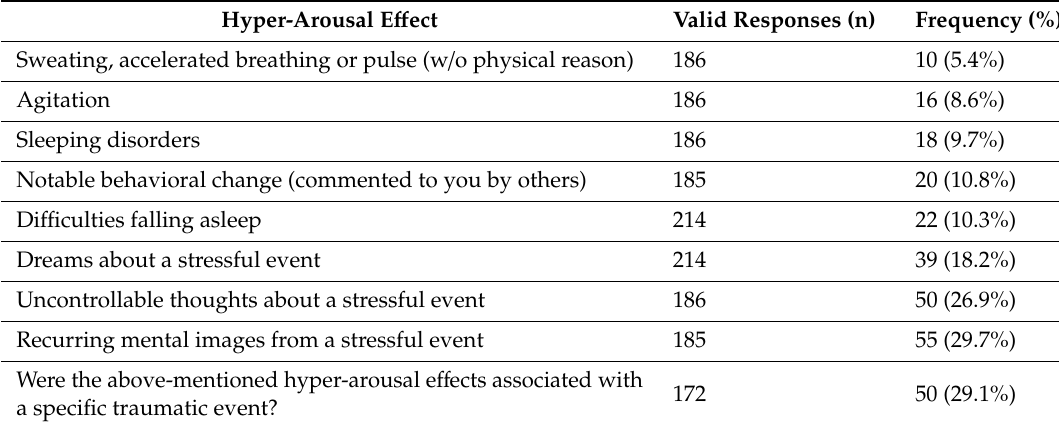
Table 2. Frequency of hyper-arousal e ff ects among MDA youth volunteers ( N = 236). Hyper-Arousal E ff ect